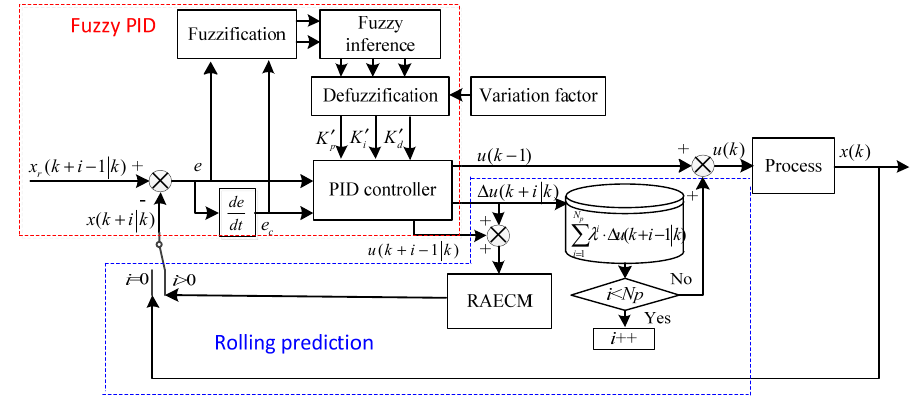
Figure 11. Block diagram of the APFPID controller.